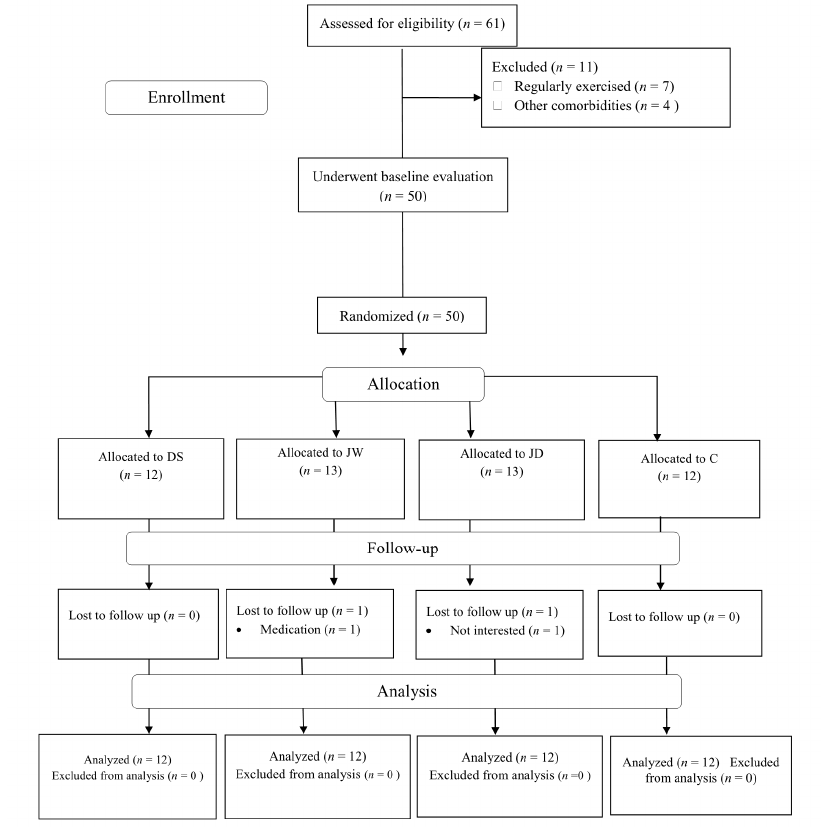
Figure 1. Participants Flow Diagram. Abbreviations: JW, jump rope exercise + white chocolate; JD, jump rope exercise + dark chocolate supplementation; DS, dark chocolate supplementation; C,